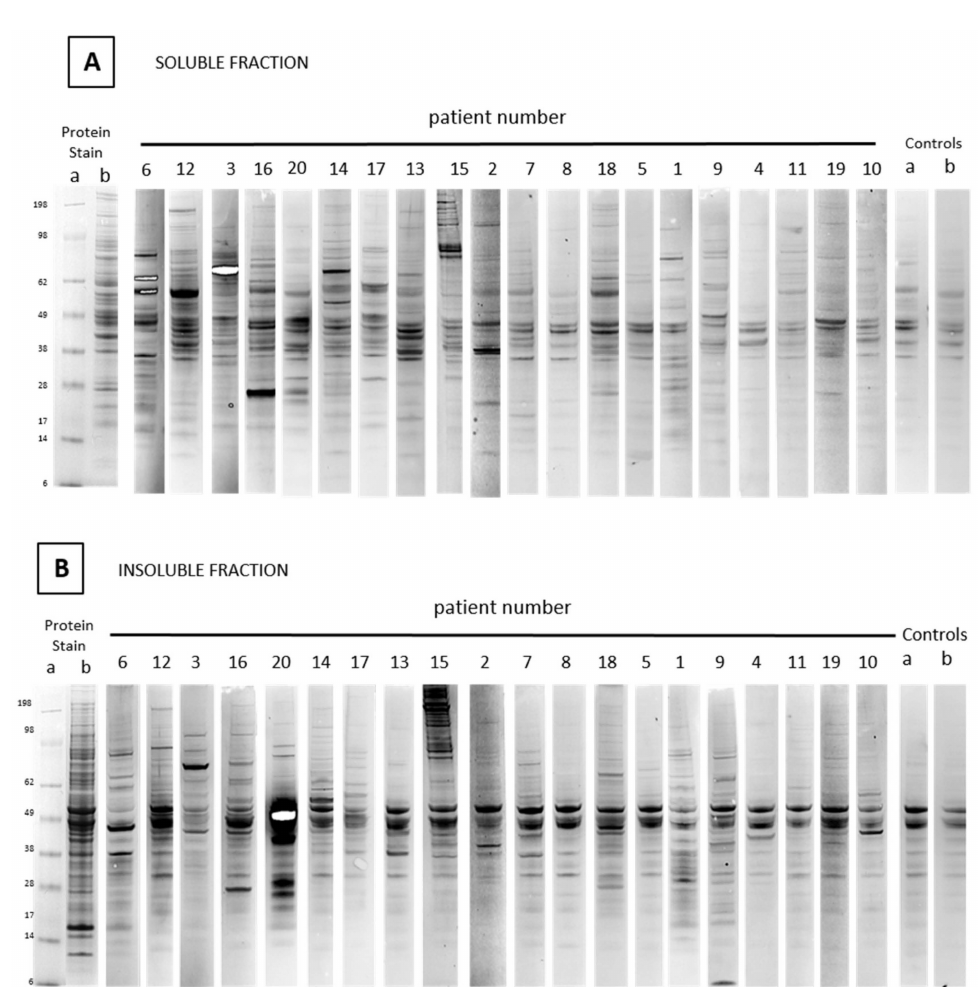
Figure 1. One-dimensional (1D) Western blots of soluble ( A ) and insoluble ( B ) fractions of MCF-7 cell extracts screened with antibody-secreting cell (ASC)-probes from 20 breast cancer patients. Molecular weight markers on the left are recorded from prestained markers (a) and the adjacent lane (b) shows the coomassie stained cell extract. Control lanes on the right are screened with serum from healthy women (a) or secondary antibody conjugate only (b). White bands are the result of extremely high levels of localized